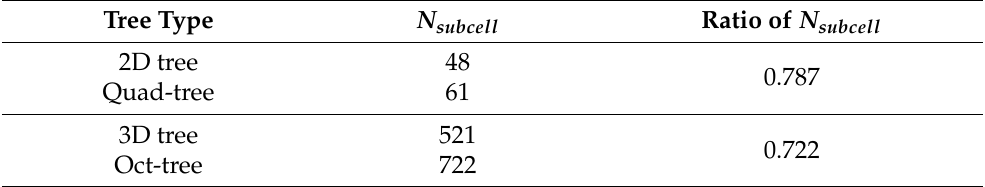
Figure 6. kd-tree subdivision of a unit cell in the presence of ( a ) a quadrant and ( b ) a one-eighth spher- ical surface. The hyper-spheres are centered at a corner and have a radius of R . The maximum level is four in both examples. The domain color represents a signed distance to the immersed boundary. Table 4. Comparison of kd-tree and quad/oct-tree subdivision in the presence of a hyper-spherical boundary as shown in Figure